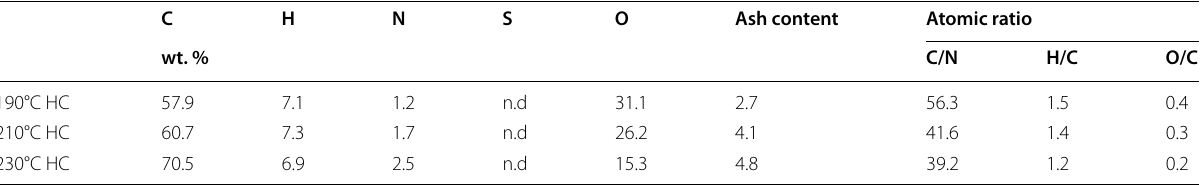
Table 1 The elemental composition (CHNS, O), ash content and calculated atomic ratios of the hydrochars produced at increasing HTC